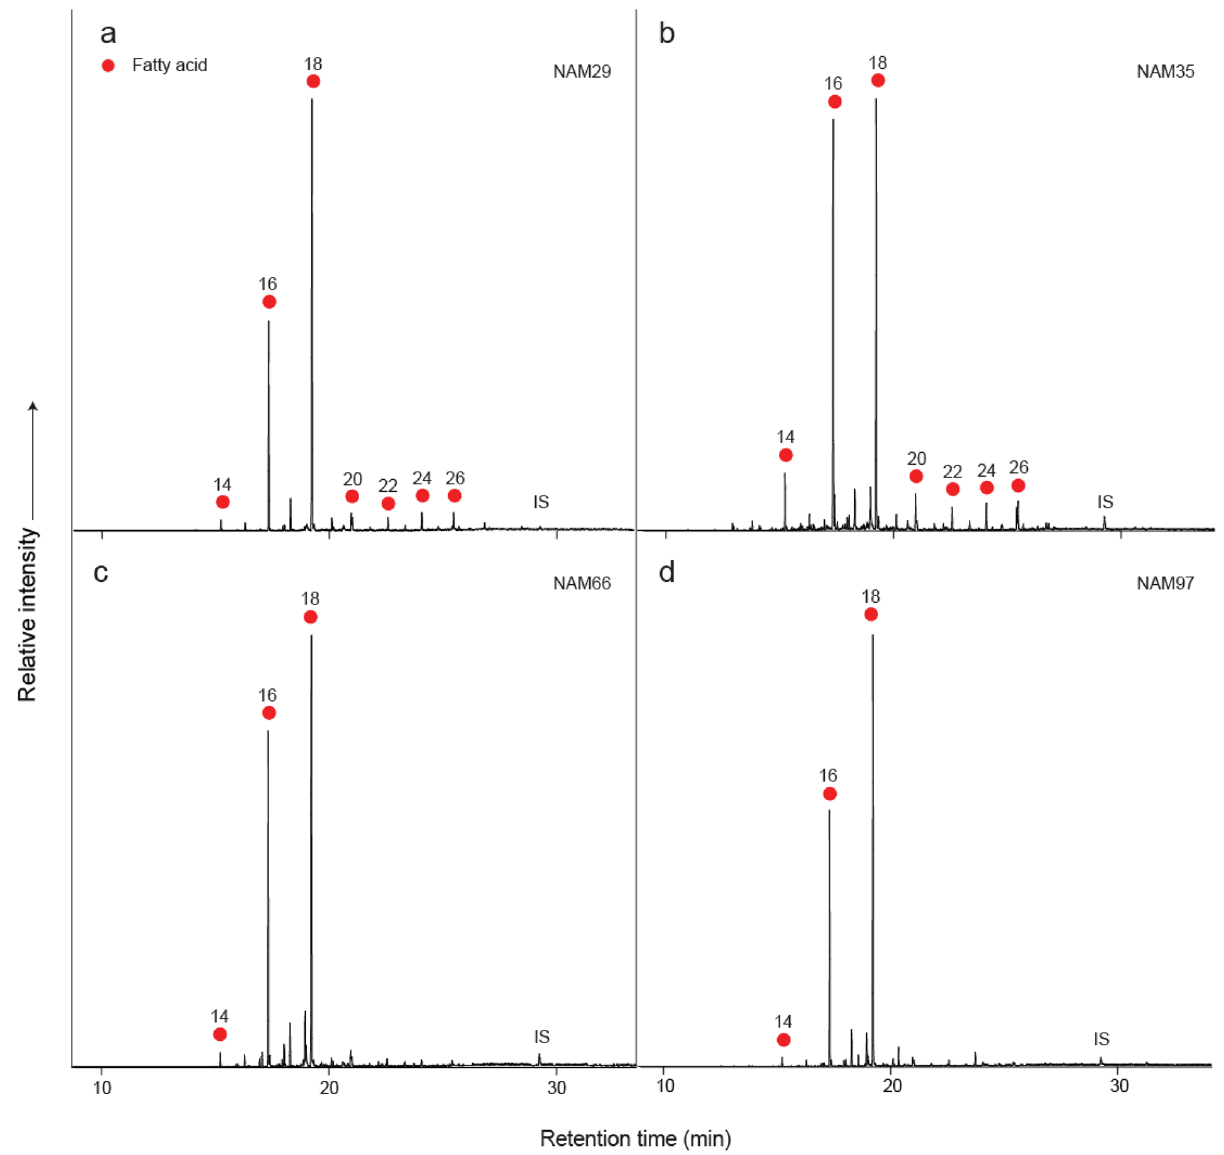
Figure 3. Partial gas chromatograms of acid-extracted FAMEs showing typical degraded animal fat lipid profiles from sites ( a ). SK2005/057, ( b ). SK2006/026, ( c ). JKB M and ( d ). JKB K. Red circles, n -alkanoic acids (fatty acids, FA), IS, internal standard, C 34 n -tetratriacontane. Number denotes carbon chain